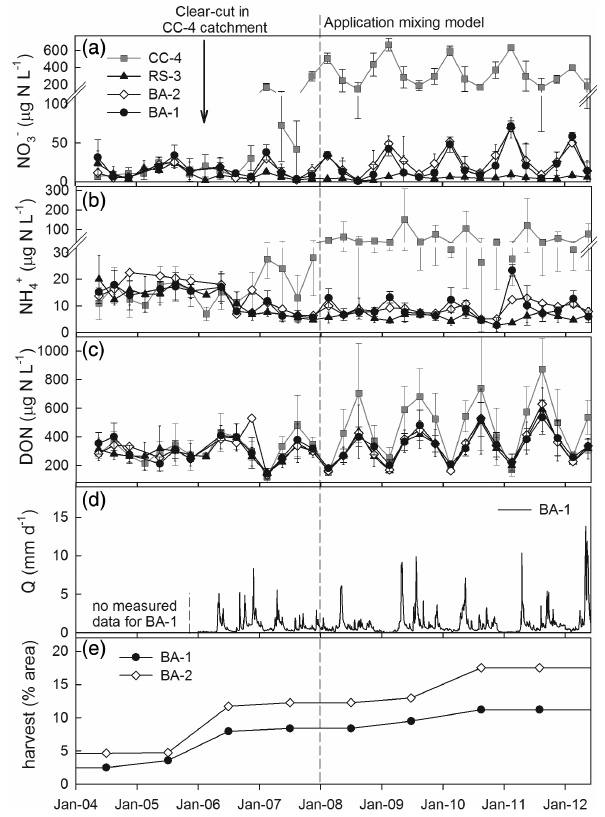
Figure 3. (a) Trimonthly nitrate (NO − ) concentrations and stan- 3 dard deviations (whiskers) of two first-order streams, the clear-cut catchment (CC-4) and the reference south (RS-3), as well as for two third-order downstream sites BA-2 (size: 8.7km 2 ) and BA-1 (size: 22.9km 2 ). (b) Trimonthly Ammonium (NH 4 ) concentrations and (c) concentrations of dissolved organic nitrogen (DON) for the same sites. (d) Discharge at the BA-1 outlet. (e) Satellite derived percentage of catchment area that has been clear-cut harvested since 2001 within BA-2 and